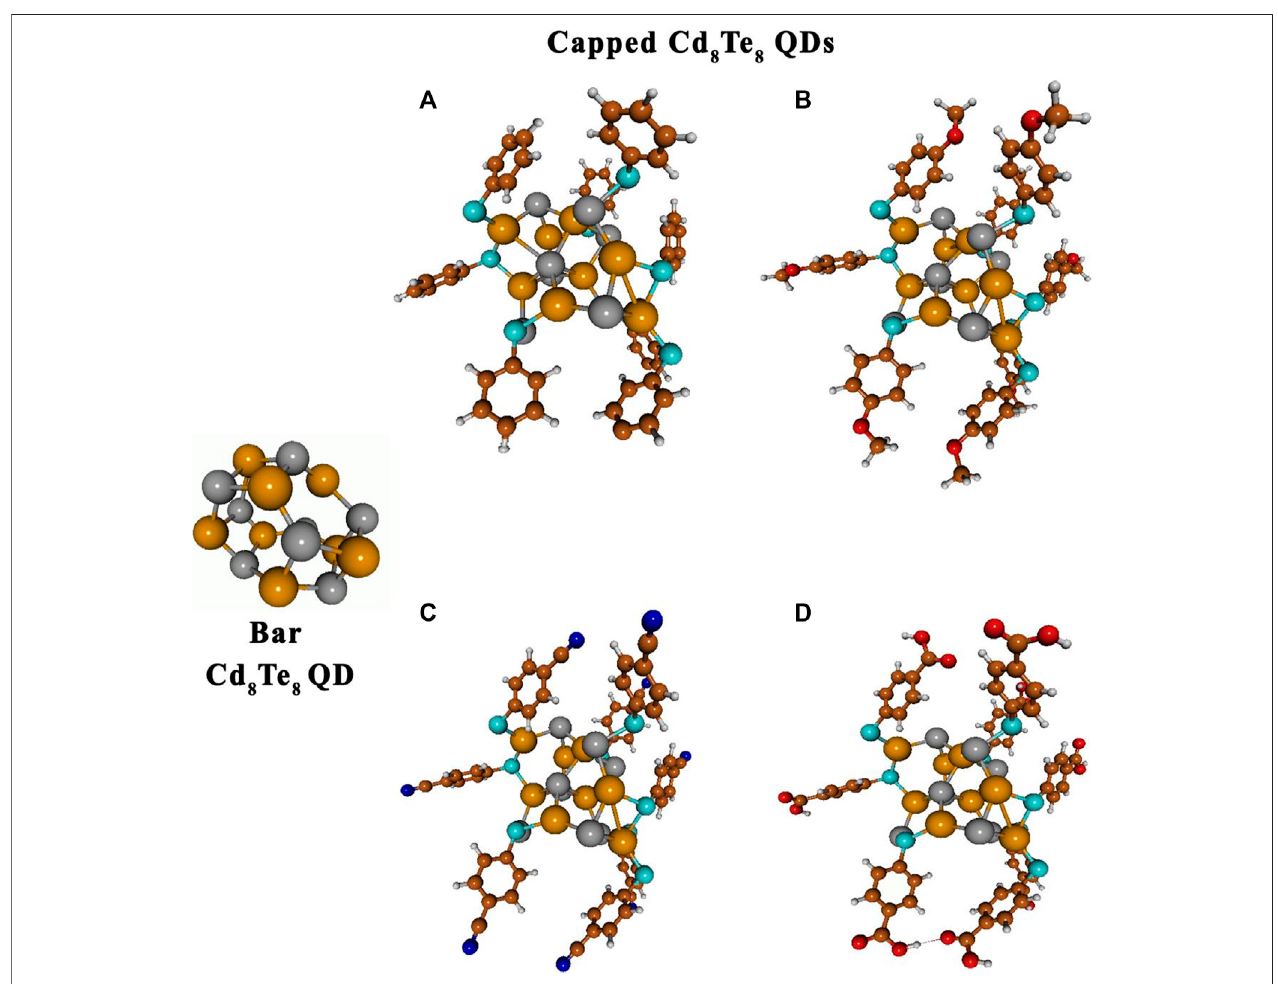
FIGURE 4 | Optimized gas-phase structures of bare and capped Cd 8 Te 8 QDs: Cd 8 Te 8 (TP) 8 (A) , Cd 8 Te 8 (MBT) 8 (B) , Cd 8 Te 8 (MBN) 8 (C) , and Cd 8 Te 8 (MBA) 8 (D) . Atomsarerepresentedasfollows:Cdbydarkyellowspheres,Tebydarkgrayspheres,Cbrownspheres,Hlightgraysphere,Oredspheres,Ssapphirespheres,andN blue